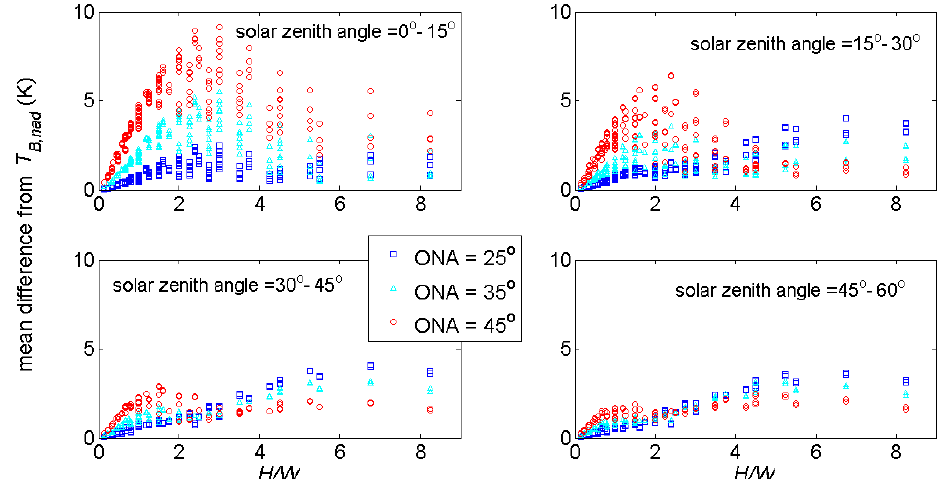
Figure 10. Mean temperature difference from nadir view as a function of H/W for three off-nadir angles (ONA), over four solar zenith angle ranges. Model output is for 1200 LST and 1800 LST for all latitudes.